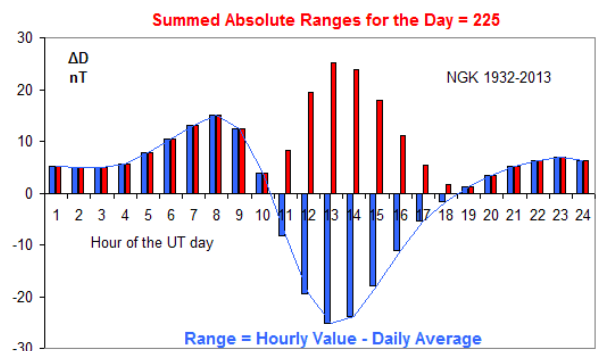
Figure 1. Average diurnal variation of declination (expressed in force units, nT) at Niemegk. On any given day, the variation con- sists of a pattern as shown here (although varying a bit from day to day) with superposed “noise” from geomagnetic activity, thus in- creasing the variance; this increase is what we are interested in. The signed deviations (blue bars determined every hour – either from an instantaneous value on the hour or from the hourly mean) from the daily mean are converted to unsigned departures (red bars), which are then summed over the day giving (as Moos expressed it) the summed ranges for each day, denoted by s